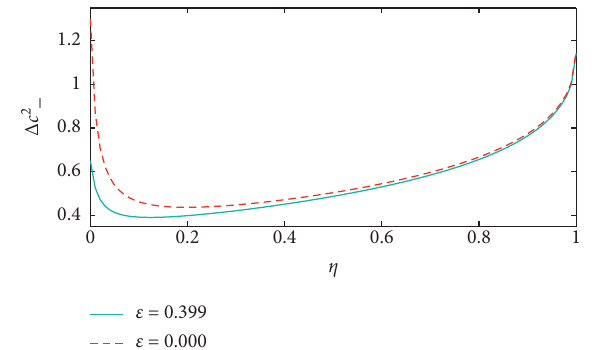
Figure 3: Plots of the minus quadrature variance (equation (25)) versus η for A � 100, κ � 0 . 8, n th � 0 . 15 and for different values of ε .